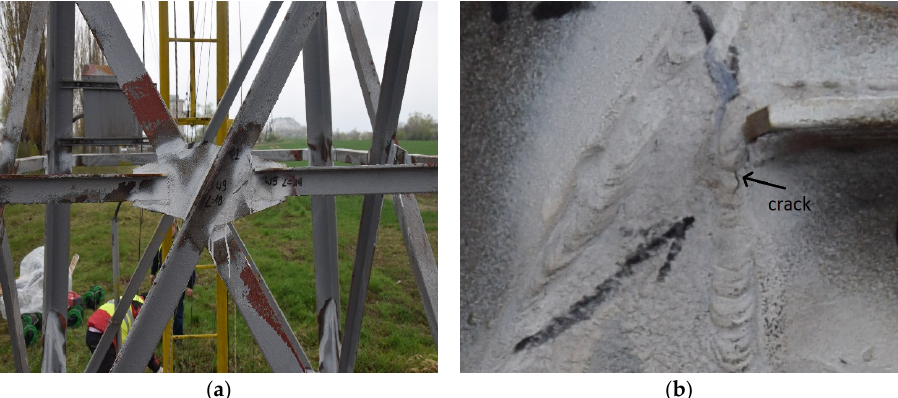
Figure 11. ( a ) Photograph of the tested node. on column 1 ( b ) A photograph of the crack detected on column 1.